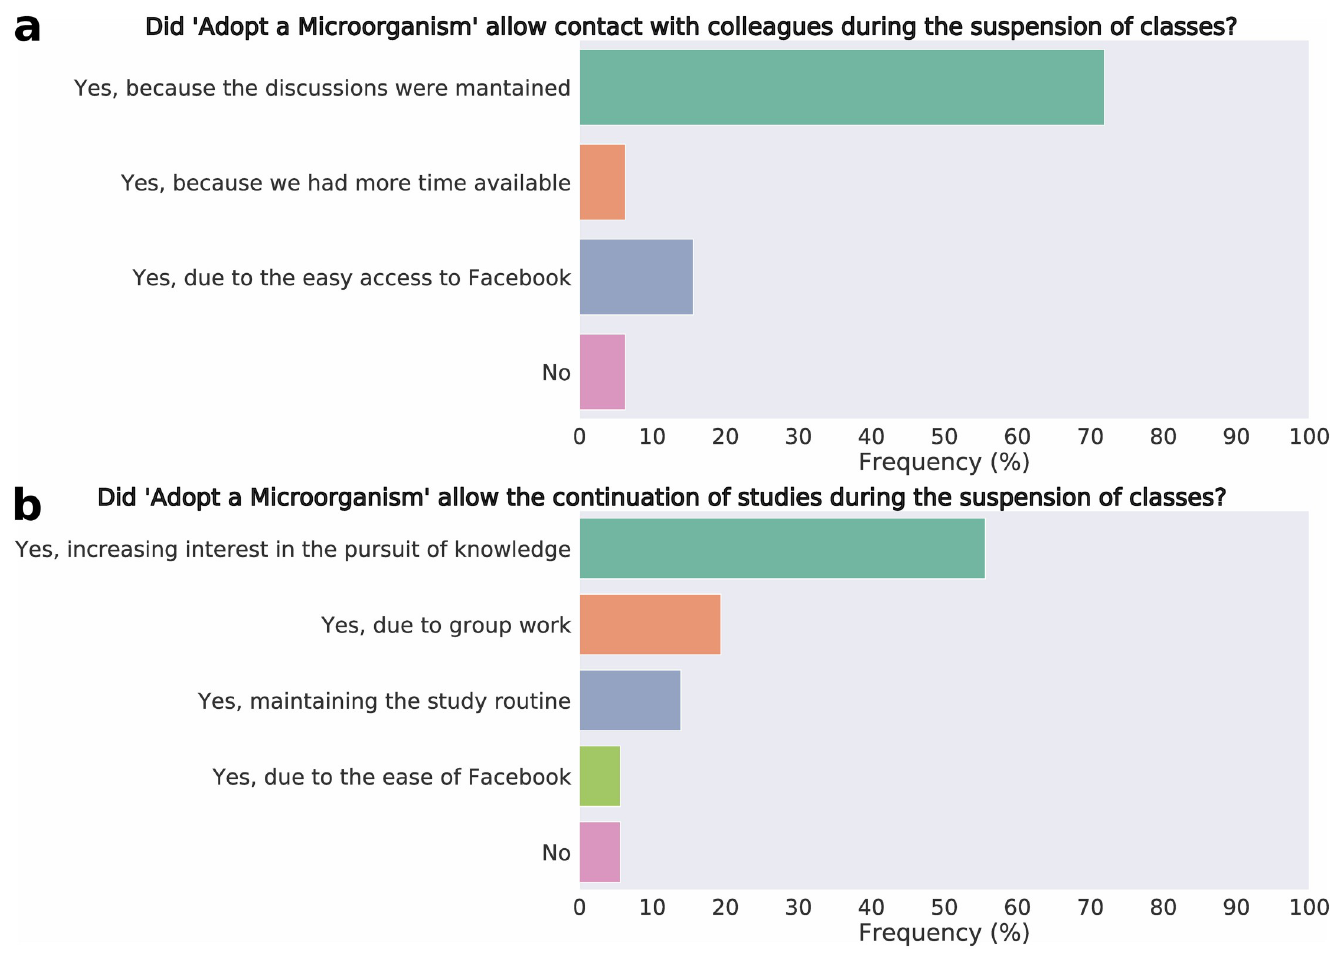
Fig 4. Students’ perceptions regarding the maintenance of “Adopt a Microorganism” during the suspension of face-to-face classes in 2020, due to the COVID- 19 pandemic. [a] impact of “Adopt a Microorganism” in maintaining contact with colleagues during the pandemic; [b] impact of “Adopt a Microorganism” on learning